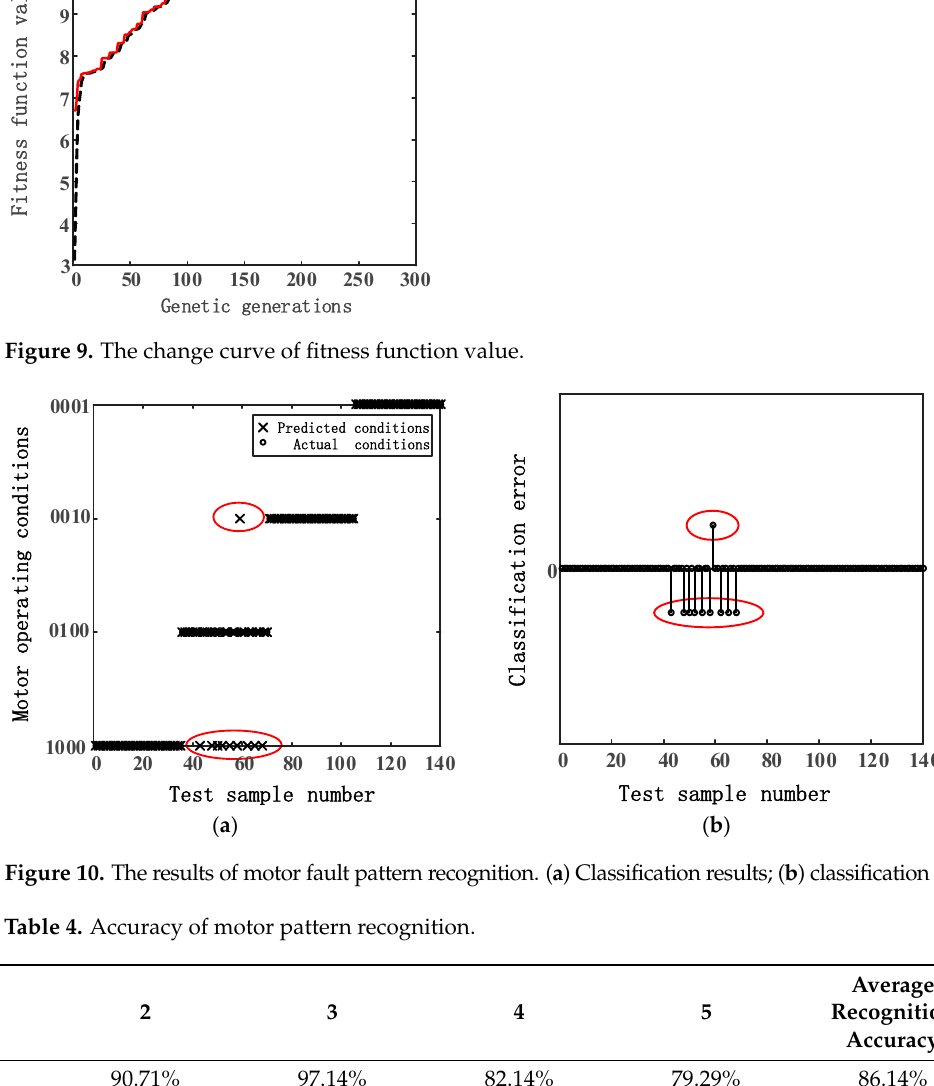
Figure 9. The change curve of fitness function value.